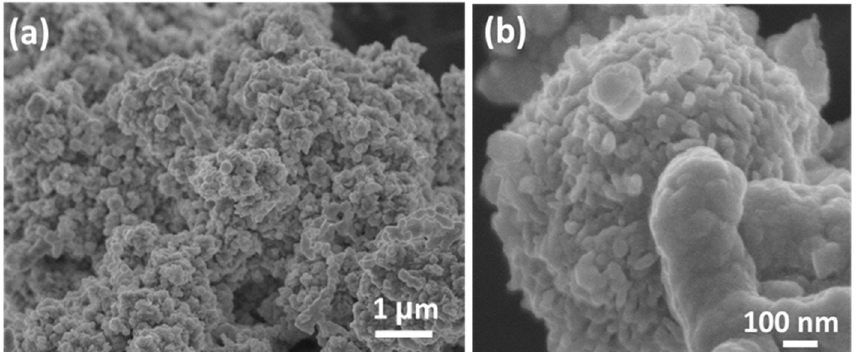
Figure 15. SEM micrographs of Co 3 O 4 nanoparticles obtained at 400 °C under air: ( a ) at low-magnification (15,000×) and ( b ) at high-magnification (60,000×).